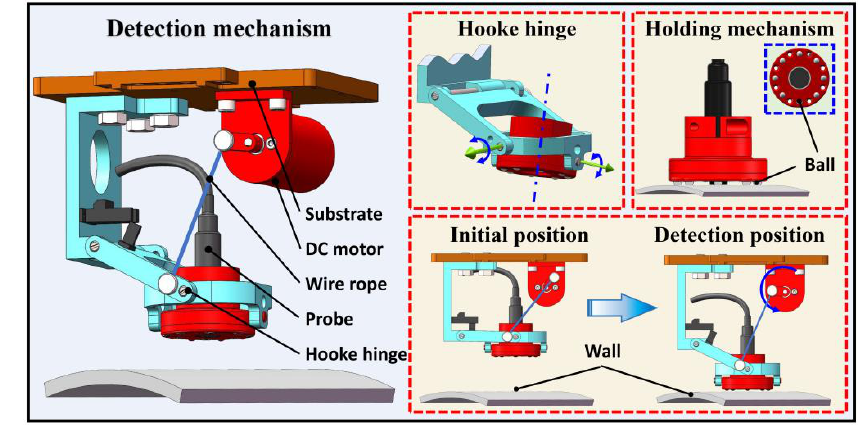
Figure 5. Flexible detection mechanism.